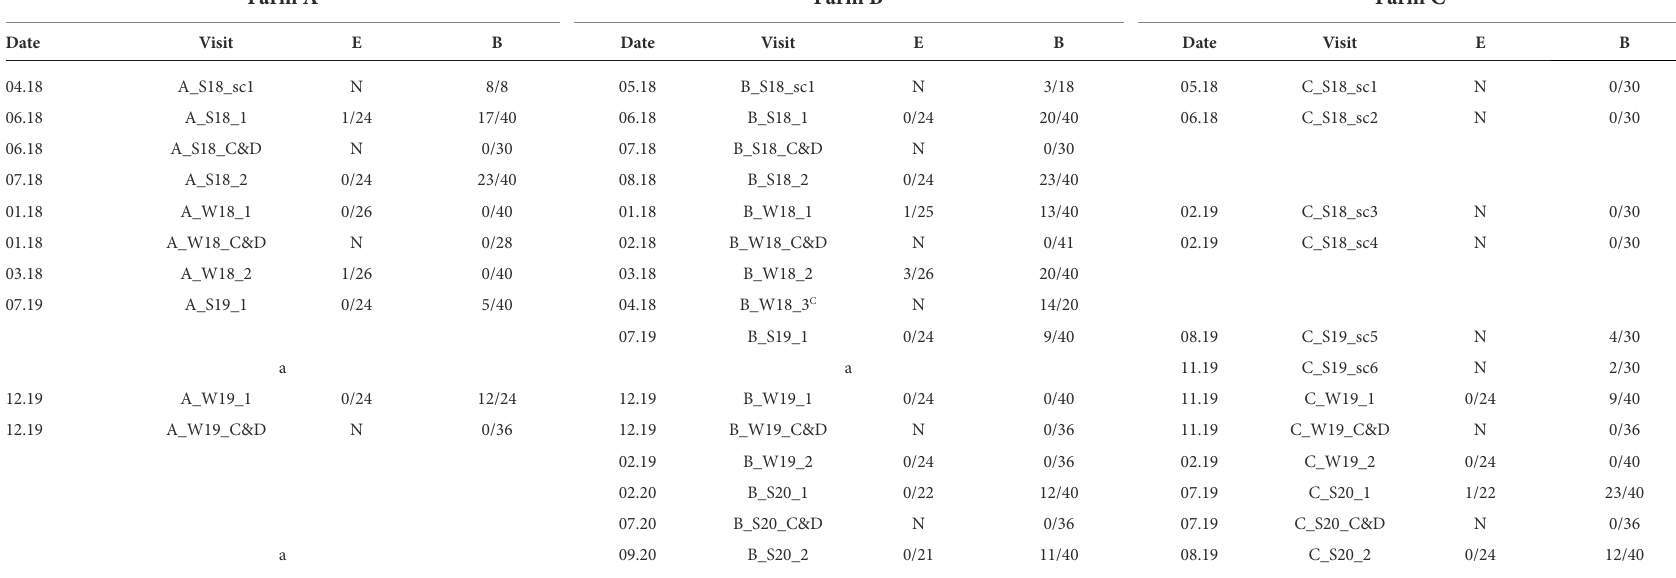
TABLE 2 Comprehensive overview of all broiler farm visits in Brandeburg, Germany,